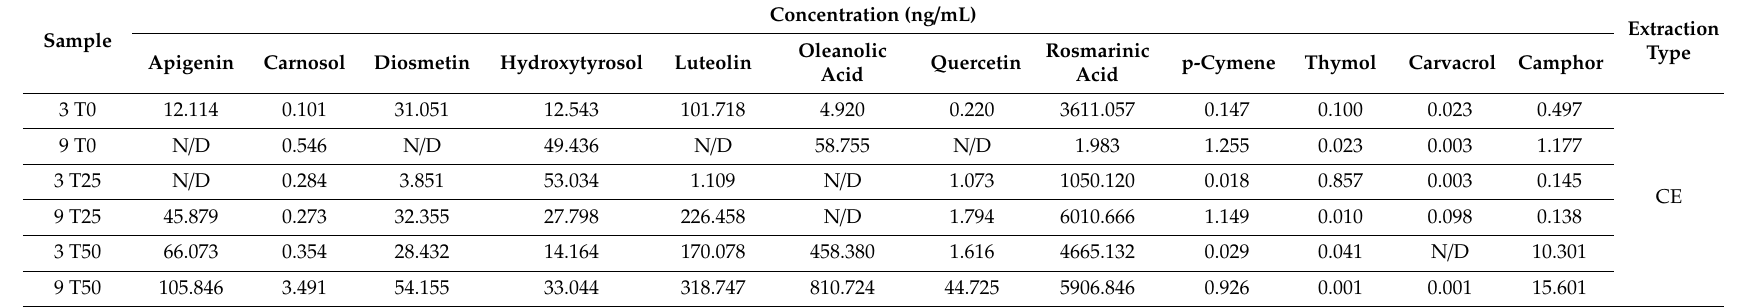
Table 4. UPLC-MS / MS analysis of extractive compounds from thyme (measurements for CE and HVED treated samples) (ng /